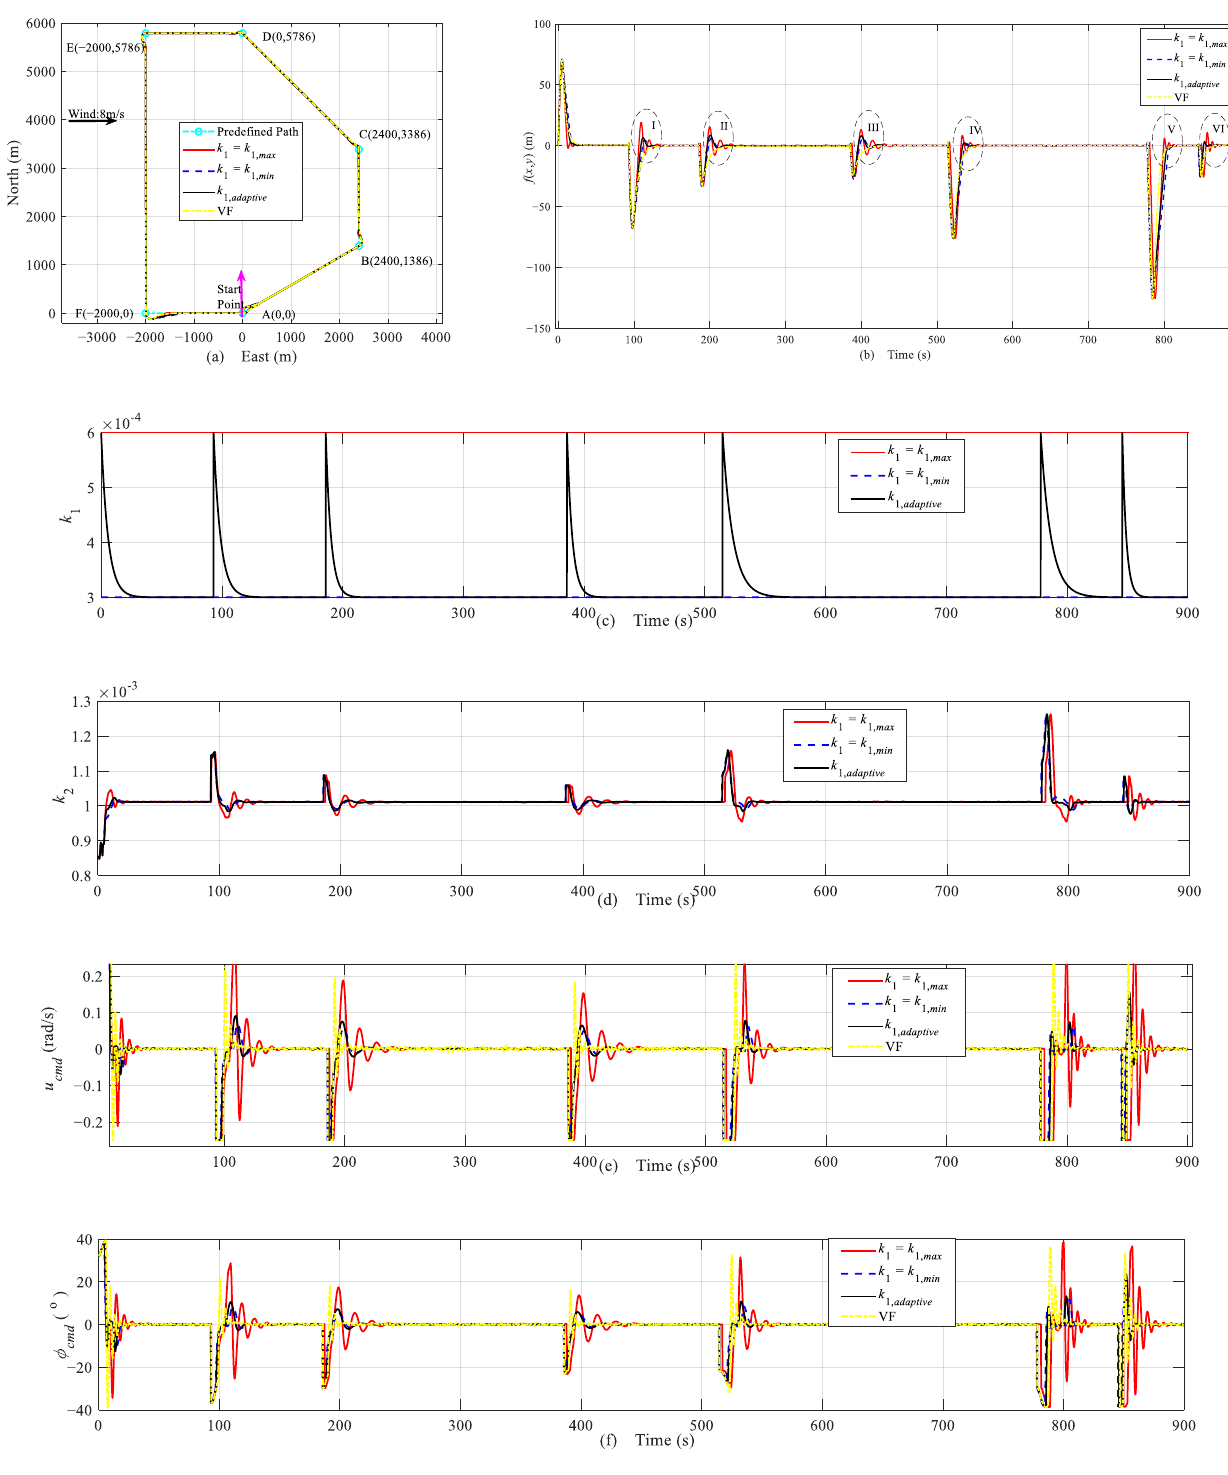
Figure 10. Comparison of the polygon path following with the four methods PFC_ k 1, max , PFC_ k 1, min , PFC − k 1, adaptive , and VF. ( a ) the position; ( b ) the distance f ( x , y ) ; ( c ) the parameter k 1 ; ( d ) the parameter k 2 ; ( e ) the course rate command u cmd ; ( f ) the bank angle command φ cmd .